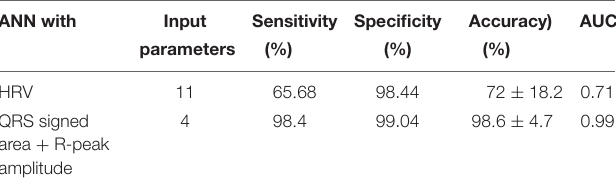
TABLE 3 | The results for the ANN in predicting VF 30 s before its occurrence.